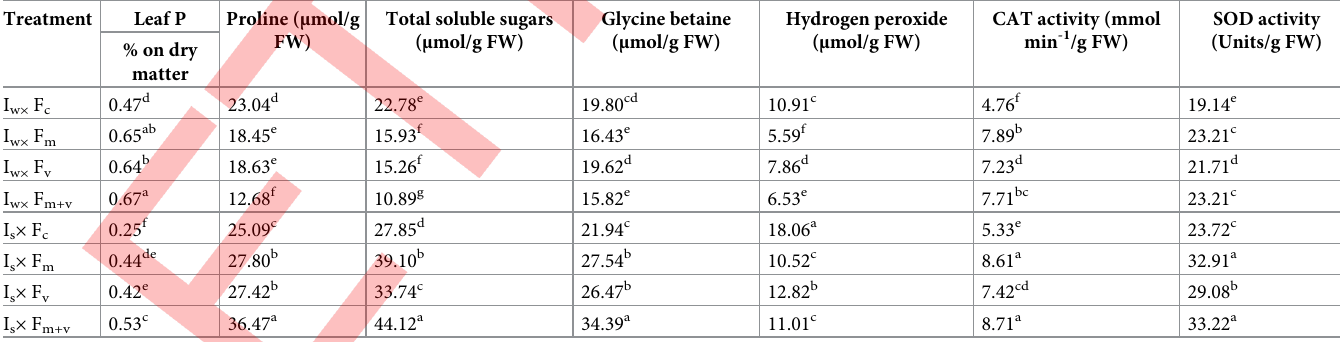
Table 4. Comparison amongst 2-year mean values of physio-biochemical traits, leaf P, total soluble sugars, catalase, and superoxide dismutase activity affected by mycorrhiza × vermicompost under full and limited irrigation. Treatment Leaf P Proline ( μ mol/g FW)